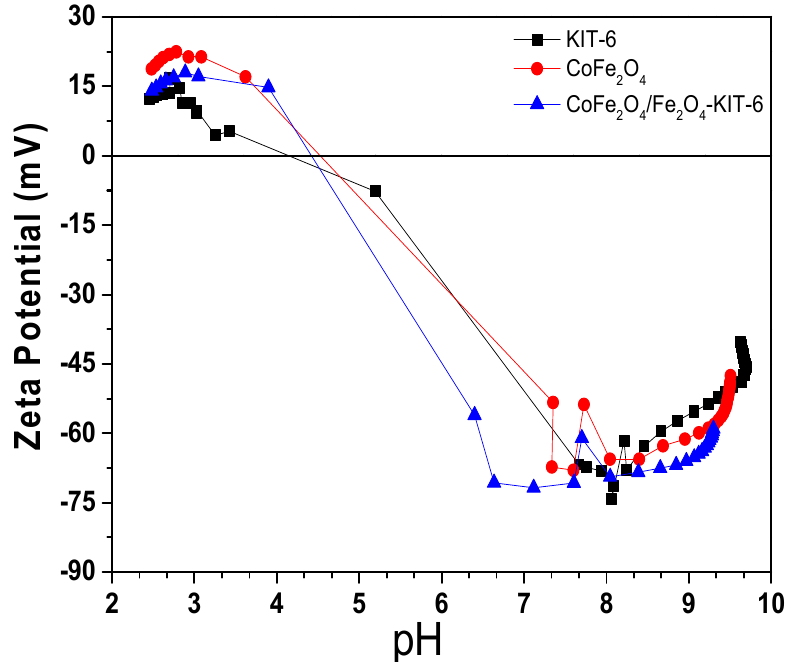
Figure 7. Zeta potential of CoFe 2 O 4 /Fe 2 O 3 -KIT-6 (blue), pure KIT-6 (black), and pure CoFe 2 O 4 (red).